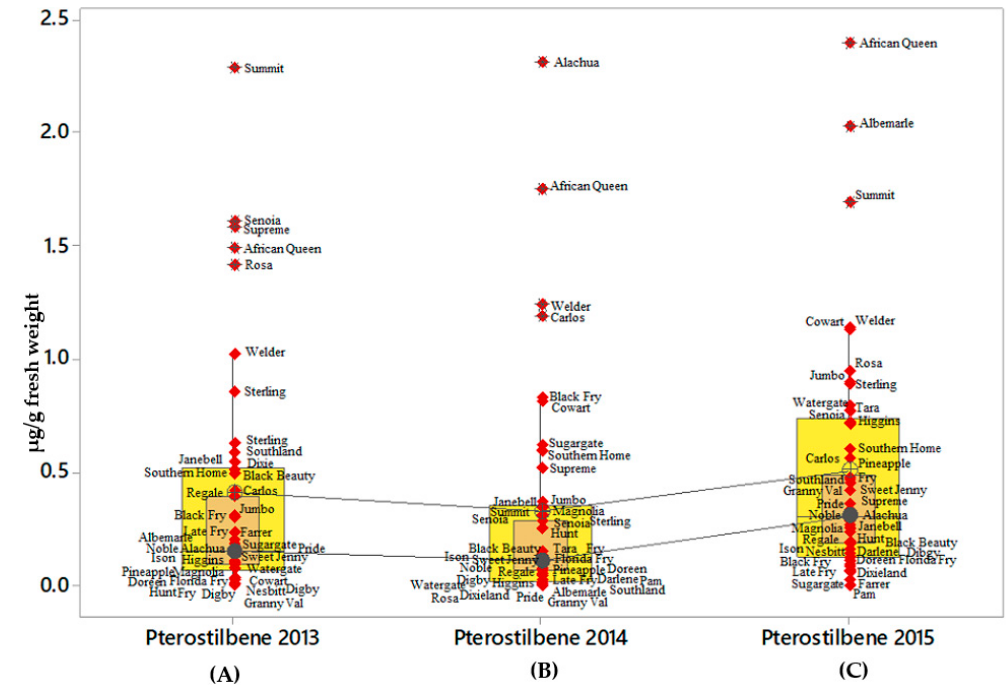
Figure 5. Differences in t -pterostilbene accumulation among muscadine cultivars. The analyzed t -pterostilbene levels from 41muscadine cultivars and plotted in the boxplots showed that 50% of the cultivars plotted in the interquartile range. The inside box showed a 95% confidence interval for the median. The line connecting individual boxplot is the median line for the t -pterostilbene levels estimated for the three consecutive years. The individual symbols show the variable data for each variety and the maximal and the minimal content levels excluding outliers are presented on the y-axis. Asterisks indicate the outliers. The boxplots A , B , and C in the figure are the average obtained from the total t -pterostilbene content in the berries for 2013, 2014, and 2015 respectively. The data was the sum of t -pterostilbene levels for each variety and obtained using three technical and biological replicates. Data obtained from cv. Fry Seedless have not been included in the figure. Table 5. Results of an analysis of variance (ANOVA) showing an interaction output for ε‐ viniferin content by year from different muscadine grape cultivars (2013–2015). Source DF SS Mean Sq. F ‐ value